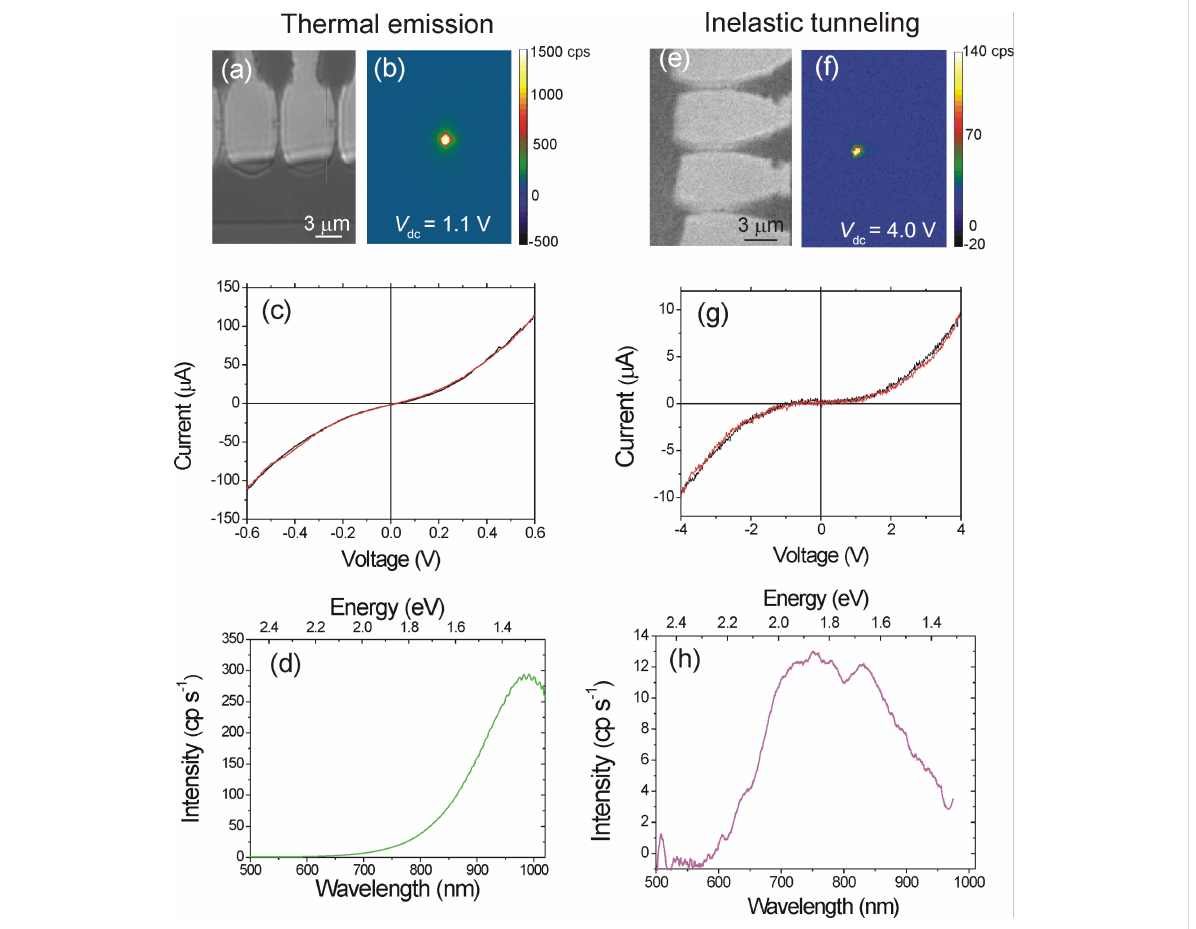
Figure 5: (a) Transmission optical image showing a series of electromigrated constrictions. (b) Optical image of the light emission when the centered junction is biased at 1.1 V. (c) Corresponding current-to-voltage characteristics where the black and red curves are the forward and backward voltage sweep, respectively. (d) Emission spectrum recorded for V dc = 0.9 V. The entire spectrum violates the quantum cutoff since h ν > eV dc . (e) and (f) are images of another series of electromigrated gaps showing the respective layout of the structure and the optical activity when the center junction is biased at 4.0 V. (g) Corresponding current-to-voltage characteristics. (h) Electroluminescent spectrum of the light-emitting device obtained at